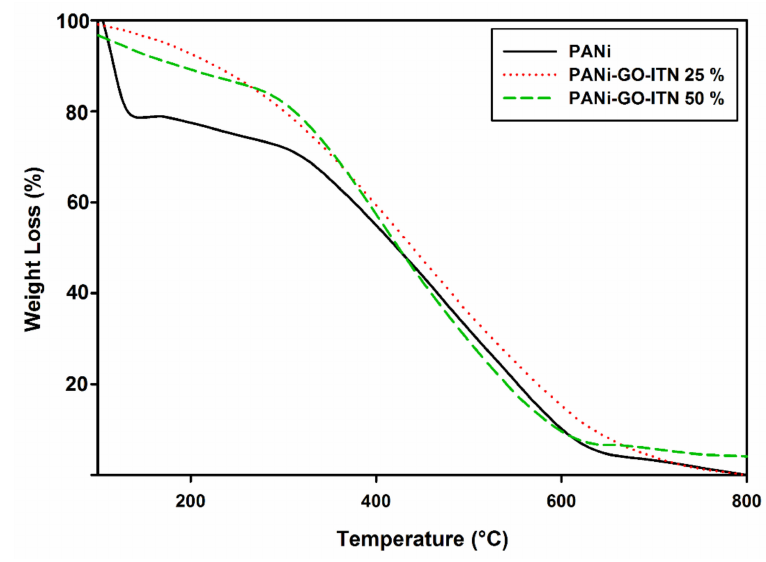
Figure 6. TGA analysis of PANi, PANi-GO-ITN 25%, and PANi-GO-ITN 50%.